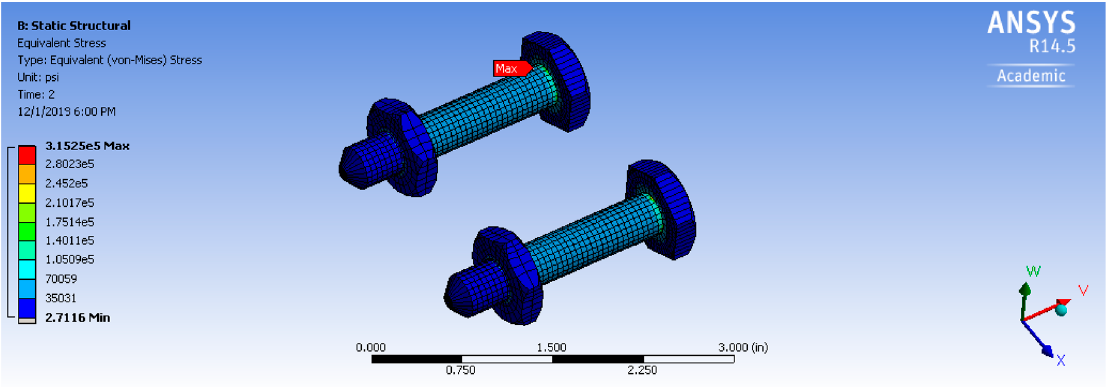
Figure 12. The equivalent stress (von Mises) of a preloaded bolted joint on the complex flanges.